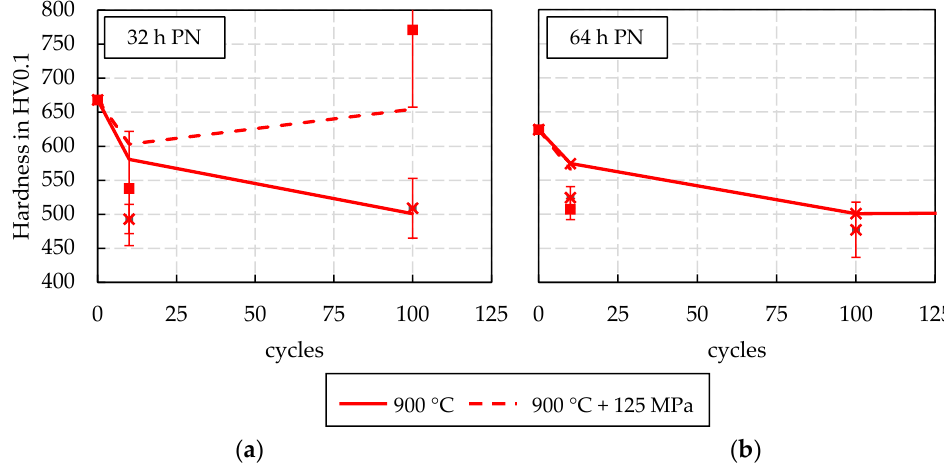
Figure 10. Results of the dynamic, cyclic tempering tests for 900 °C peak temperature: ( a ) 32 h PN, ( b ) 64 h PN.